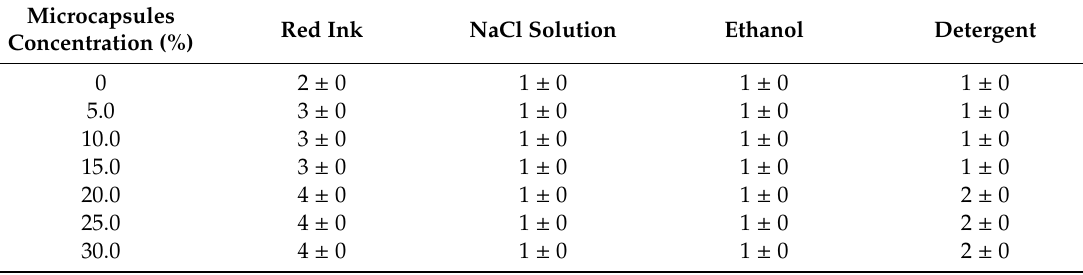
Table 8. E ff ect of microcapsule concentration on liquid